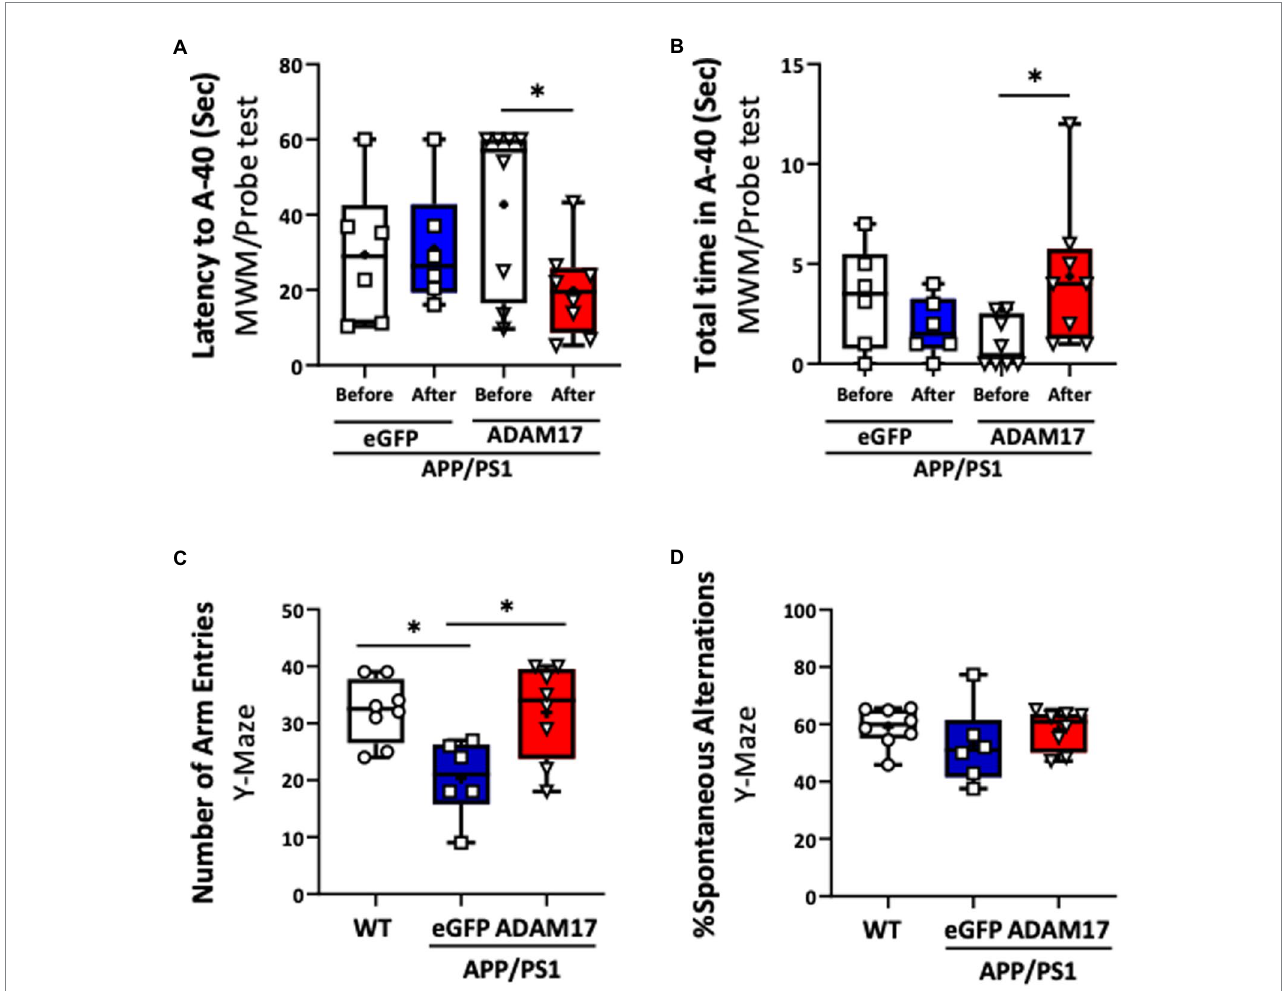
FIGURE 3 Increased ADAM17 expression improves cognitive function of APP/PS1 mice. (A,B) ADAM17 overexpressed APP/PS1 mice show a reduced latency (seconds) to reach the target area and increased total time in the target area compared to before ADAM17-AAV (adeno-associated virus) injection in a MWM probe test. There was no difference in APP/PS1 mice after receiving an eGFP-AAV9 injection. (C,D) The number of arm entries was lower in APP/PS1 mice with eGFP-AAV9 injected mice compared to the WT mice. This number was improved in the APP/PS1 mice with ADAM17-AAV9 virus injection. There was no difference in the percent of spontaneous alternation between the WT mice, eGFP, or ADAM17 overexpressed APP/PS1 mice in a spontaneous Y-Maze test. * P < 0.05. n =6 − 8. Unpaired t test was